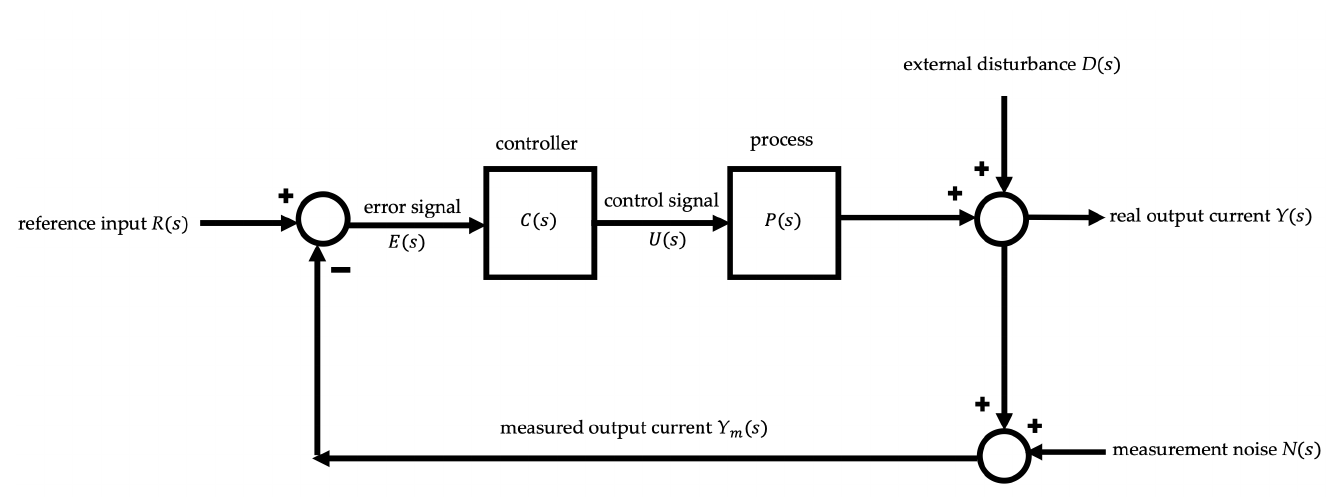
Figure 7. Diagram of a feedback loop response for the entire continuous MEC control process.